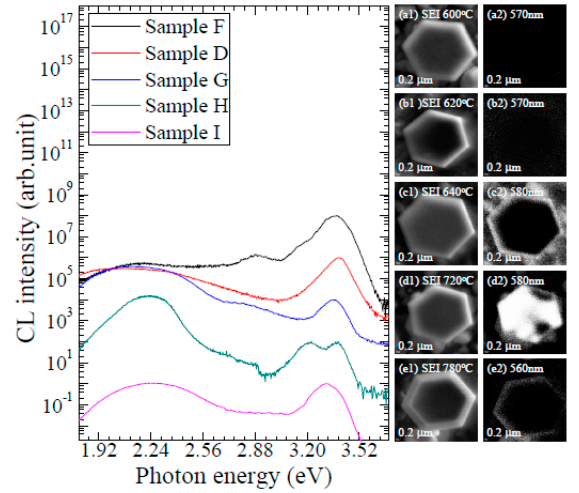
Figure 5. The CL spectra measure at room temperature for samples F, G, H, D, and I. ( a1 )–( e1 ) show their SEI images. ( a2 )–( e2 ) show the CL images of the samples for wavelengths of 570 nm,570 nm, 580 nm, 580 nm, and 560 nm, respectively. Table IV. The summary of CL peaks, FWHMs, and In contents for the samples of series II.